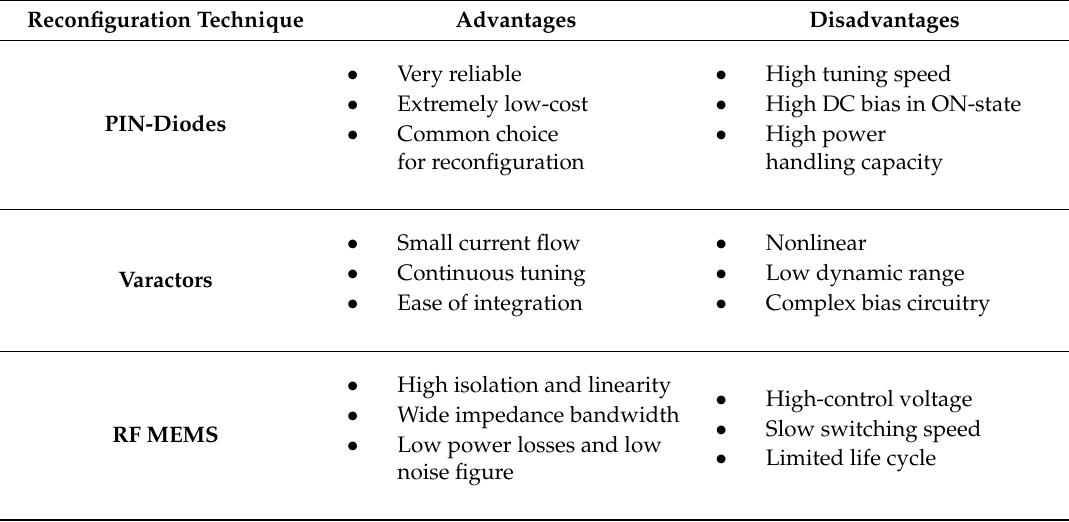
Table 1. A comparison of di ff erent switch components